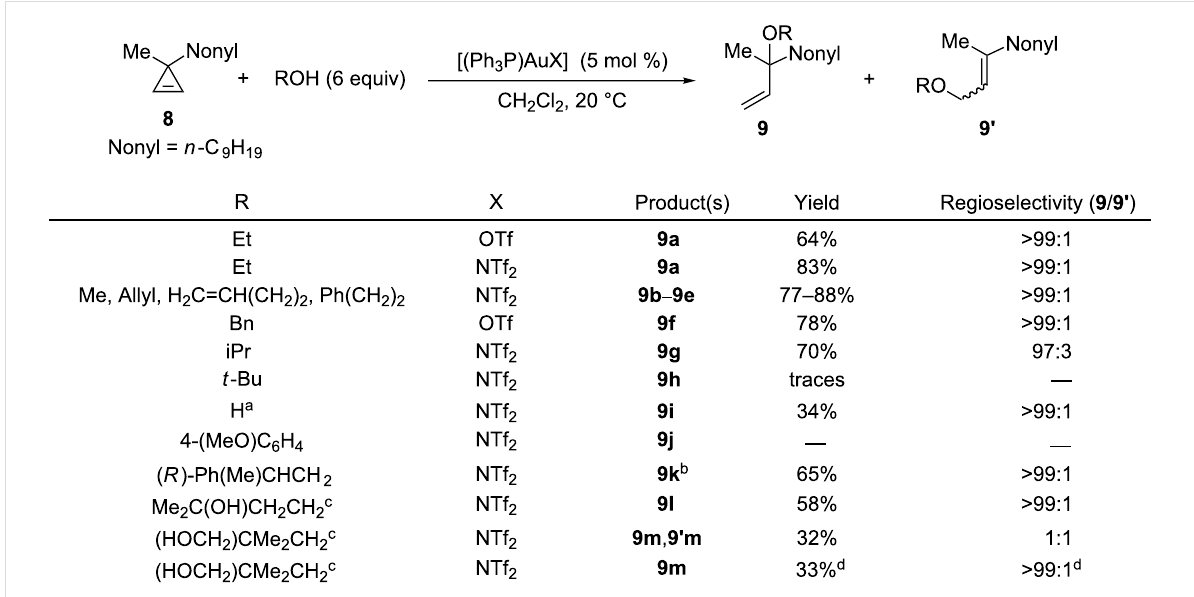
Scheme 5: Gold-catalyzed addition of alcohols or water to cyclopropene 8